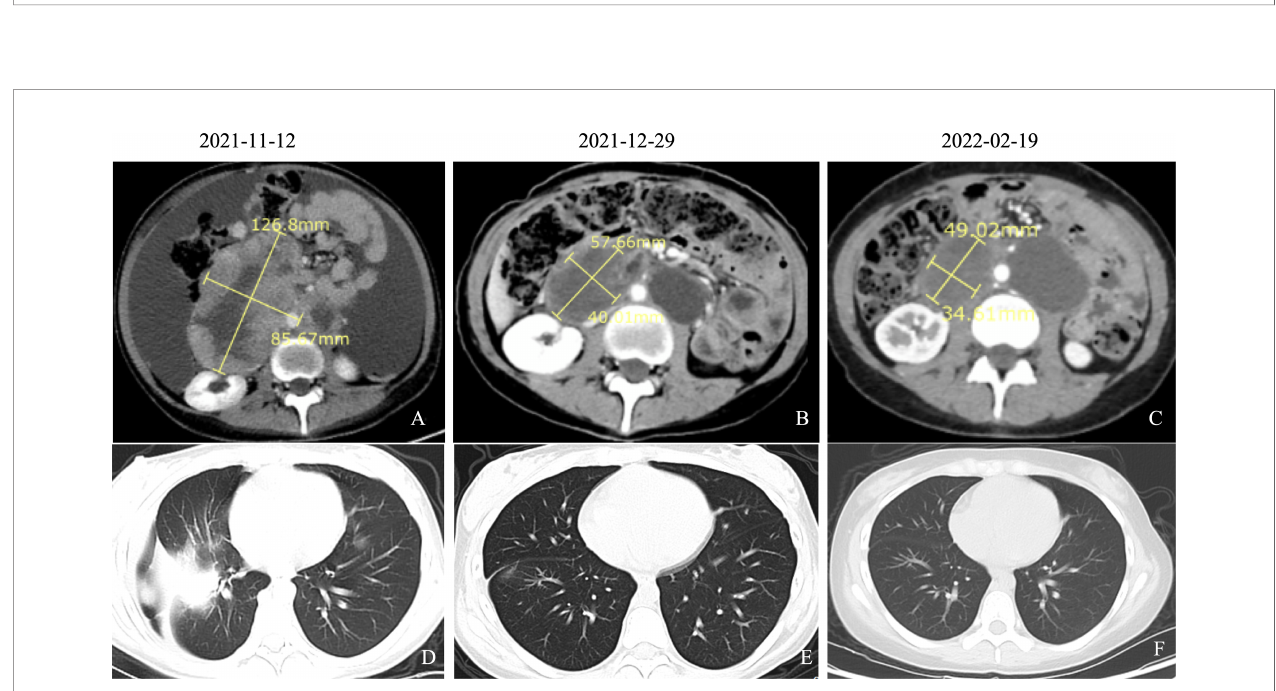
FIGURE 2 | CT fi ndings of pelvic sarcomas and lung metastasis over the course of patient ’ s treatment. (A) Abdominal CT scan (November 12, 2021) showed abdominal and pelvic lesions, blurred surrounding intestinal fat space, and multiple enlarged lymph nodes behind the peritoneum, which were similar to the previous fi ndings (October 20, 2021). Abdominal and pelvic effusions were more advanced than before. (B) Abdominal CT scan (December 29, 2021) showed abdominopelvic space occupation, blurred surrounding intestinal fat space, multiple enlarged lymph nodes in the retroperitoneum, and lesions smaller than previously observed (November 12, 2021). (C) Abdominal CT scan (February 19, 2022) showed abdominopelvic multiple occupancy, blurring of surrounding intestinal fat spaces, multiple enlarged lymph nodes in the retroperitoneum, and partial reduction of previous (December 29, 2021) lesions. (D) Chest CT scan (November 12, 2021) showed right pleural effusion with atelectasis, right pulmonary nodule, and possible metastasis. (E) Chest CT scan (December 29, 2021) showed the right pulmonary nodules disappeared compared to the previous ones, and new nodules were observed (possible metastasis). (F) Chest CT scan (February 19, 2022) showed the right pulmonary nodule disappeared compared with the anterior